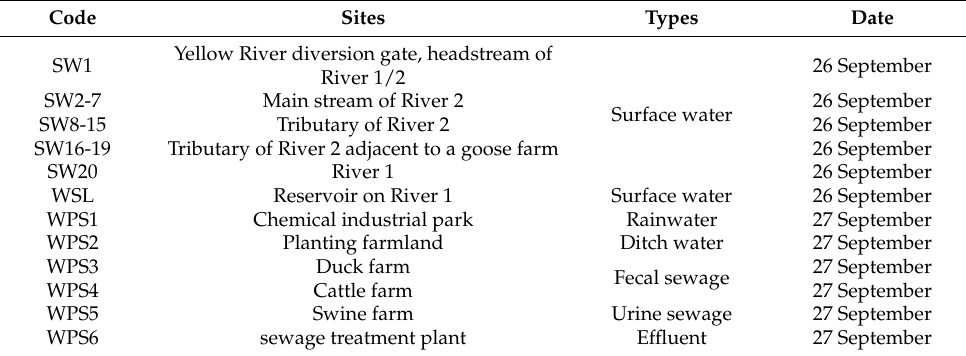
Table 1. Sampling sites in the selected study area.